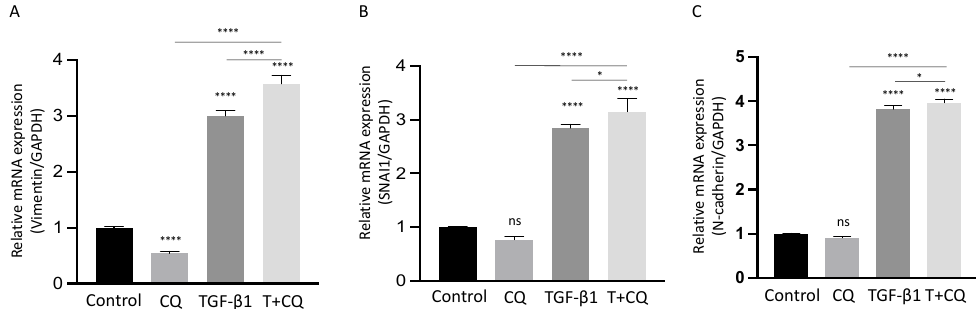
Figure 5. Autophagy inhibition does not suppress transcription of EMT-related genes in TGF- β 1- treated A549 cells. ( A – C ) The relative mRNA levels of SNAI1 ( A ), N-Cadherin (CDH2) ( B ), Vimentin (VIM) ( C ) were determined by Q-PCR in the indicated treatments after 24 h. mRNA levels normalized to GAPDH . Data represent the mean ± s.d of three independent experiments. **** p < 0.0001, * p < 0.05 values were determined by one-way ANOVA with Tukey’s